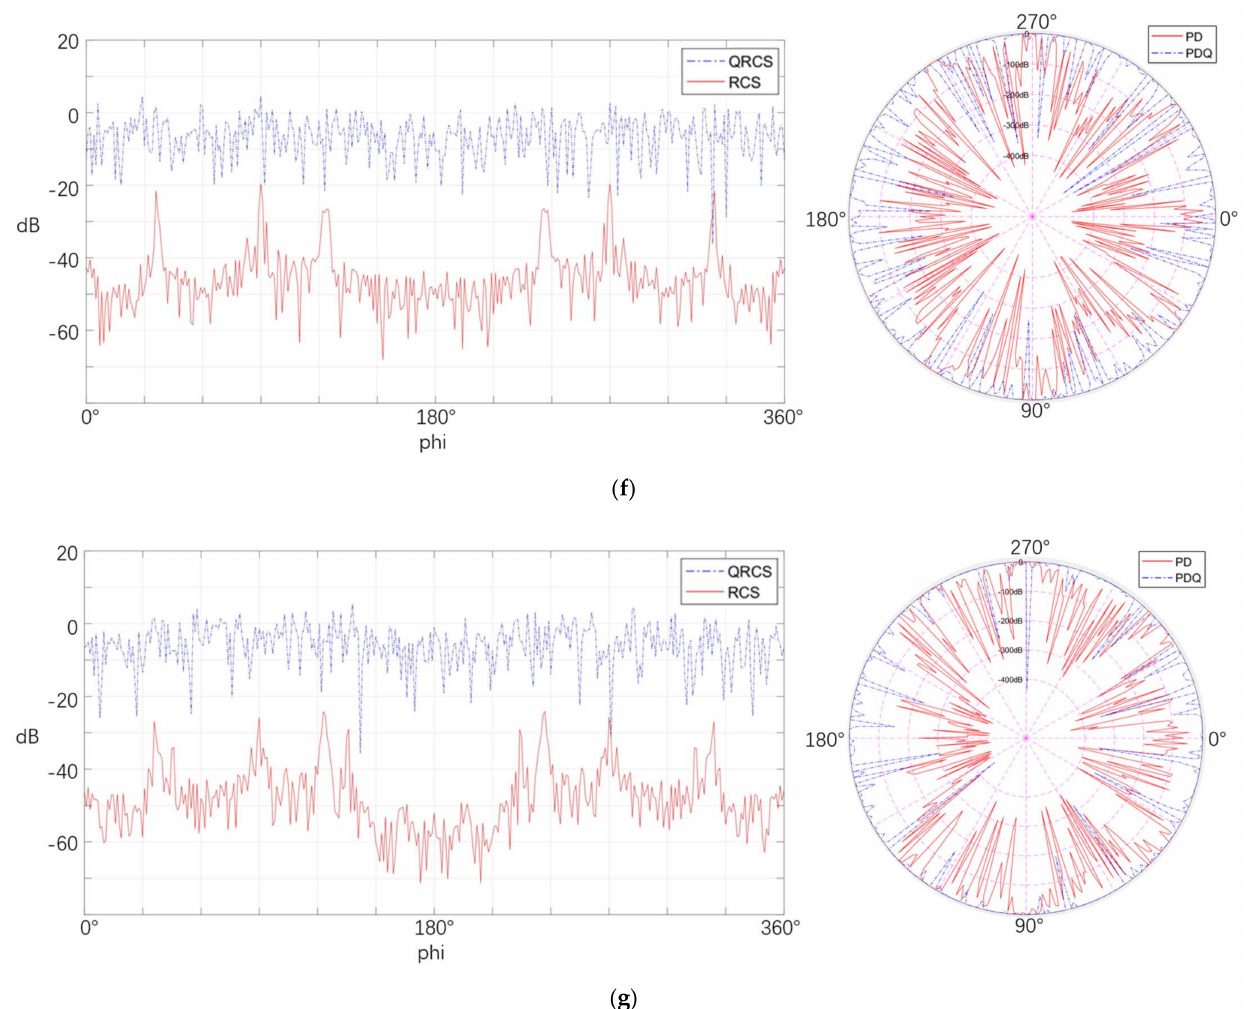
Figure 19. Comparison of detection probability between the quantum radar and the conventional radar at different frequencies. ( a ) 1.1 GHz, ( b ) 2.9 GHz, ( c ) 3.7 GHz, ( d ) 4.4 GHz, ( e ) 5.5 GHz, ( f ) 8.1 GHz, ( g ) 10 GHz. Table 3 calculates the mean values of the two detection probabilities. The feature shown in this table is that, with the increase in frequency, the detection probability of the